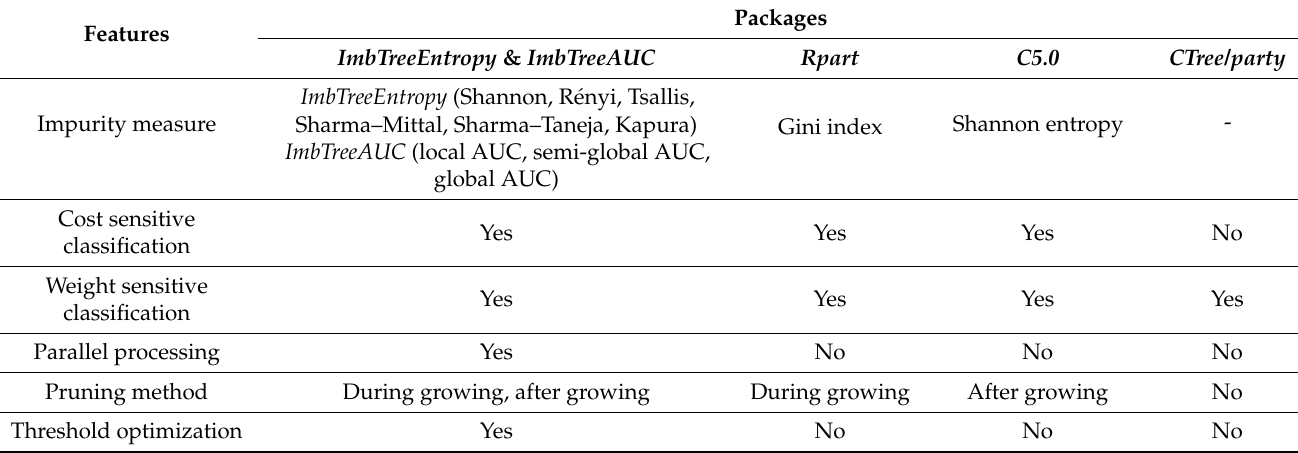
Table 2. Comparison between authors’ algorithms and other for R packages